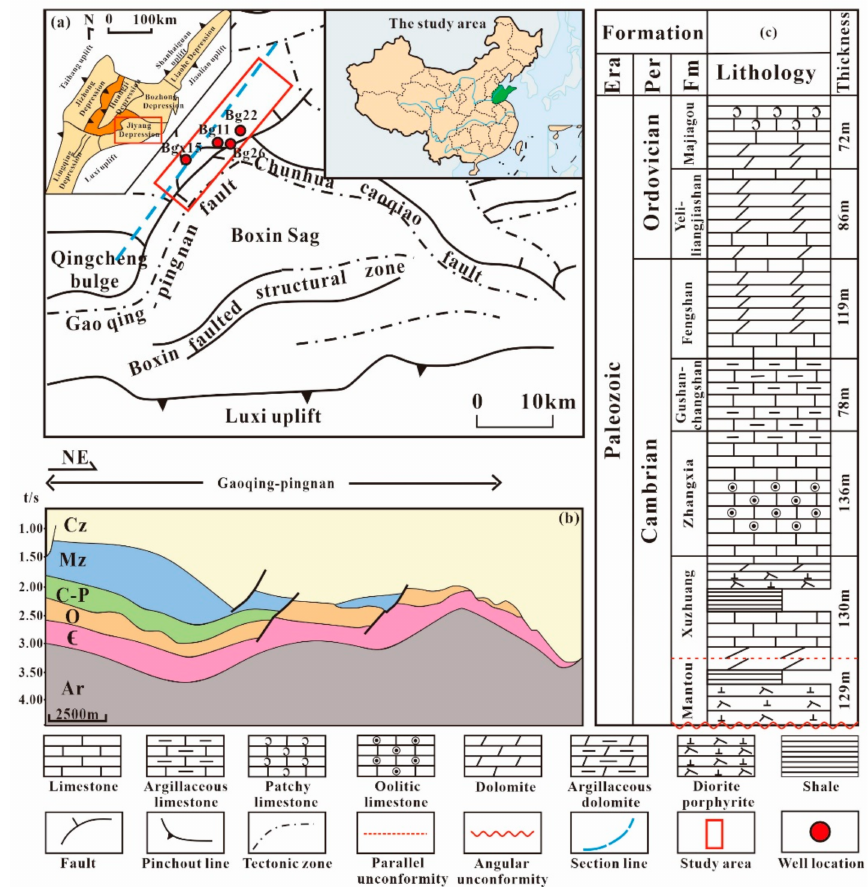
Figure 1. ( a ) Tectonic setting of the Dongying Depression, Bohai Bay Basin; ( b ) characteristics of formation development in NE-trending strata profile; section line is shown in ( a ); ( c ) stratigraphy of the Lower Paleozoic Formation in Dongying Depression, Bohai Bay Basin (modified after [44]). The map of China is quoted from